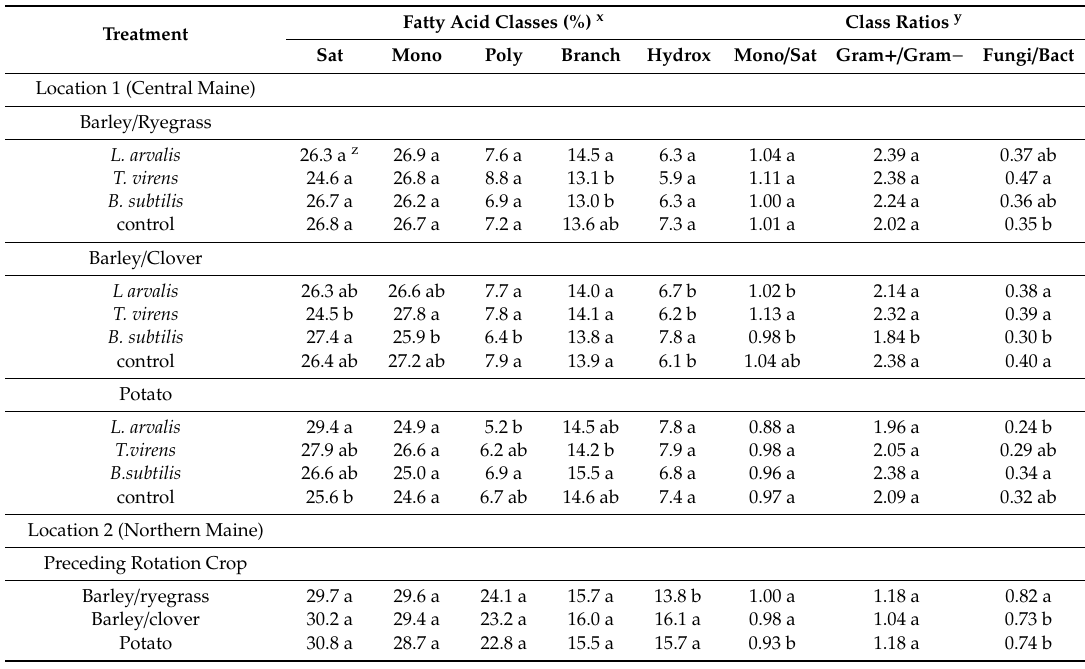
Table 6. E ff ects of biocontrol treatments as a ff ected by preceding rotation crop at location 1 and e ff ects of preceding rotation crops and biocontrol treatments at location 2 in August year 2 on di ff erent fatty acid structural classes and class